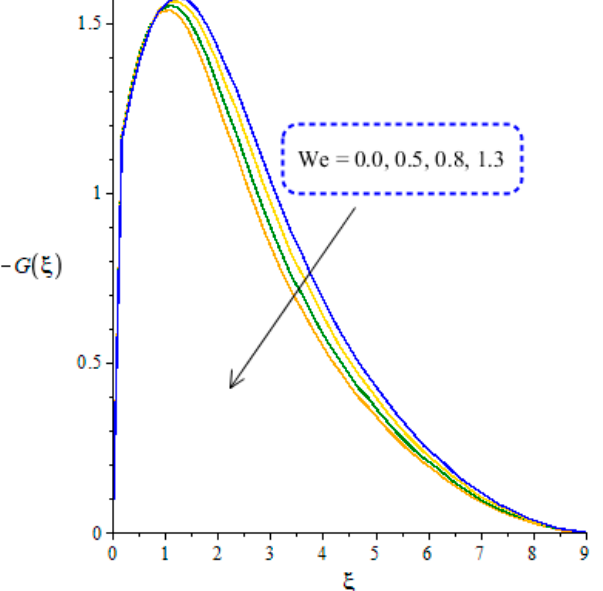
Figure 3. Variation role of − G ( ξ ) versus We when m = 0.5, Ω = 3.0, M 2 = 0.1, β e = 0.3, β i = 0.1, Figure 3. Variation role of −𝐺(𝜉) versus 𝑊𝑒 when 𝑚 = 0.5,Ω = 3.0,𝑀 (cid:2870) = 0.1, 𝛽 (cid:3032) = 0.3,𝛽 (cid:3036) = (cid:101) = 0.04, F r = 2.0, Pr = 204, Ec = 0.3, ϕ 2 = 0.0075, ϕ 1 = 0.002, ϕ 3 = 0.1, 𝜖 = 0.04, 𝐹 (cid:3045) = 2.0, 𝑃𝑟 = 204, 𝐸𝑐 = 0.3,𝜑 (cid:2870) = 0.0075, 𝜑 (cid:2869) = 0.002,𝜑 (cid:2871) = 0.005.